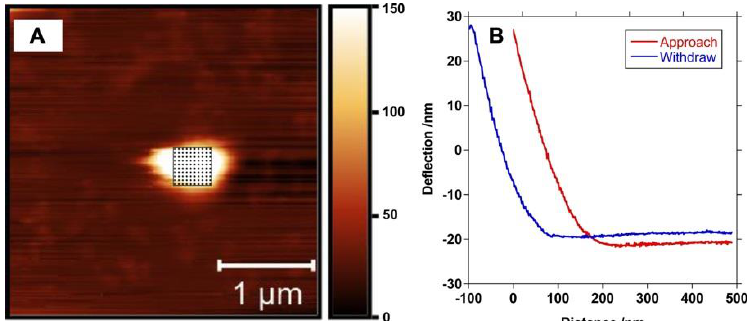
Figure 3. Differential scanning calorimetry (DSC) of GSK3787, PBSe-NDL, and PBSe-GSK3787. DSC shows a T m for the drug and for phase separated drug in the particles. Particles both with and without drug had very similar T g values, again suggesting phase separation of the drug in the particles.